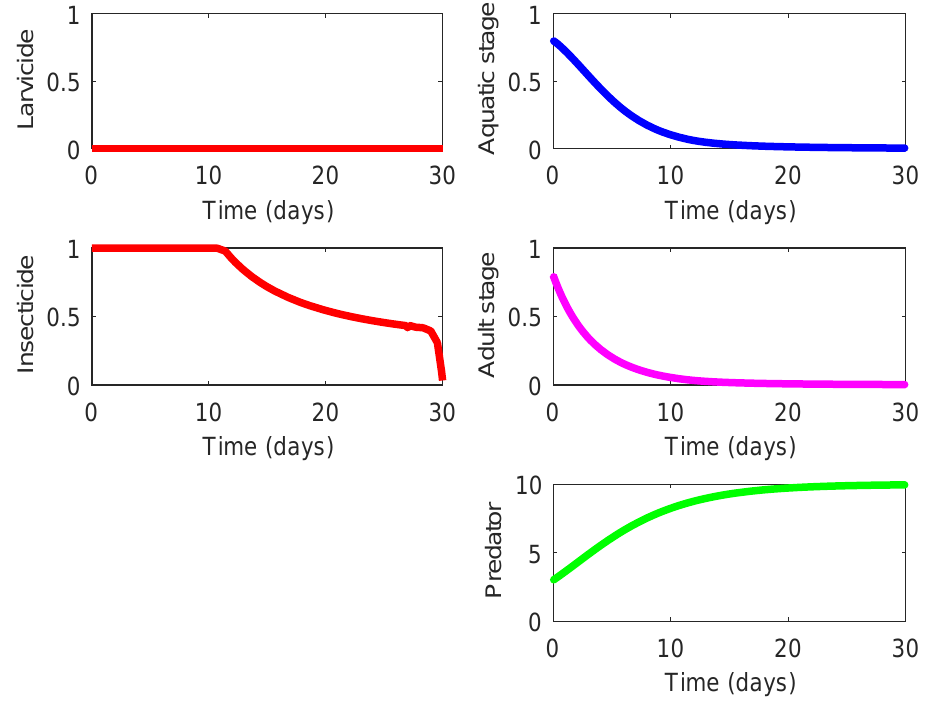
Figure 6. State and control profiles of the system (1) under Strategy 110: presence of inefficient or inert predator combined with application of low-lethality insecticide.